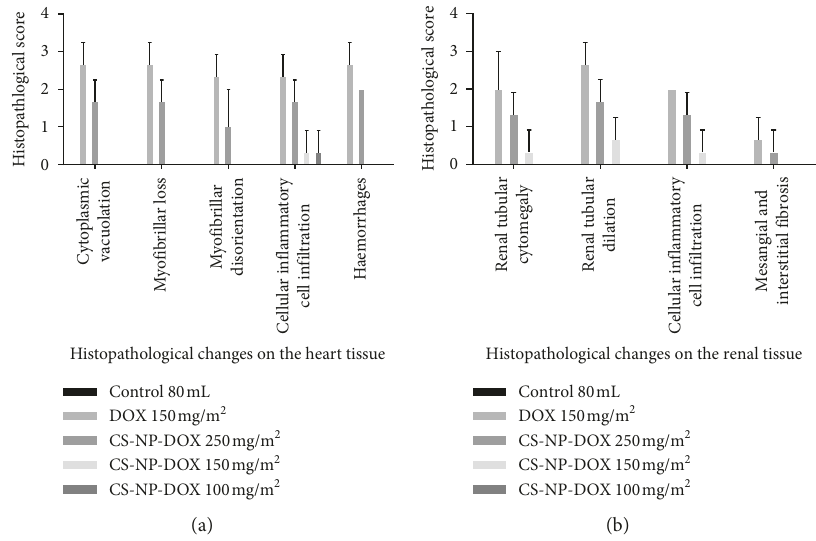
Figure 9: Semiquantitative analysis of both left ventricular myocardial muscle and the renal tissue of the experimental dogs. All the data are expressed as mean SD. ±